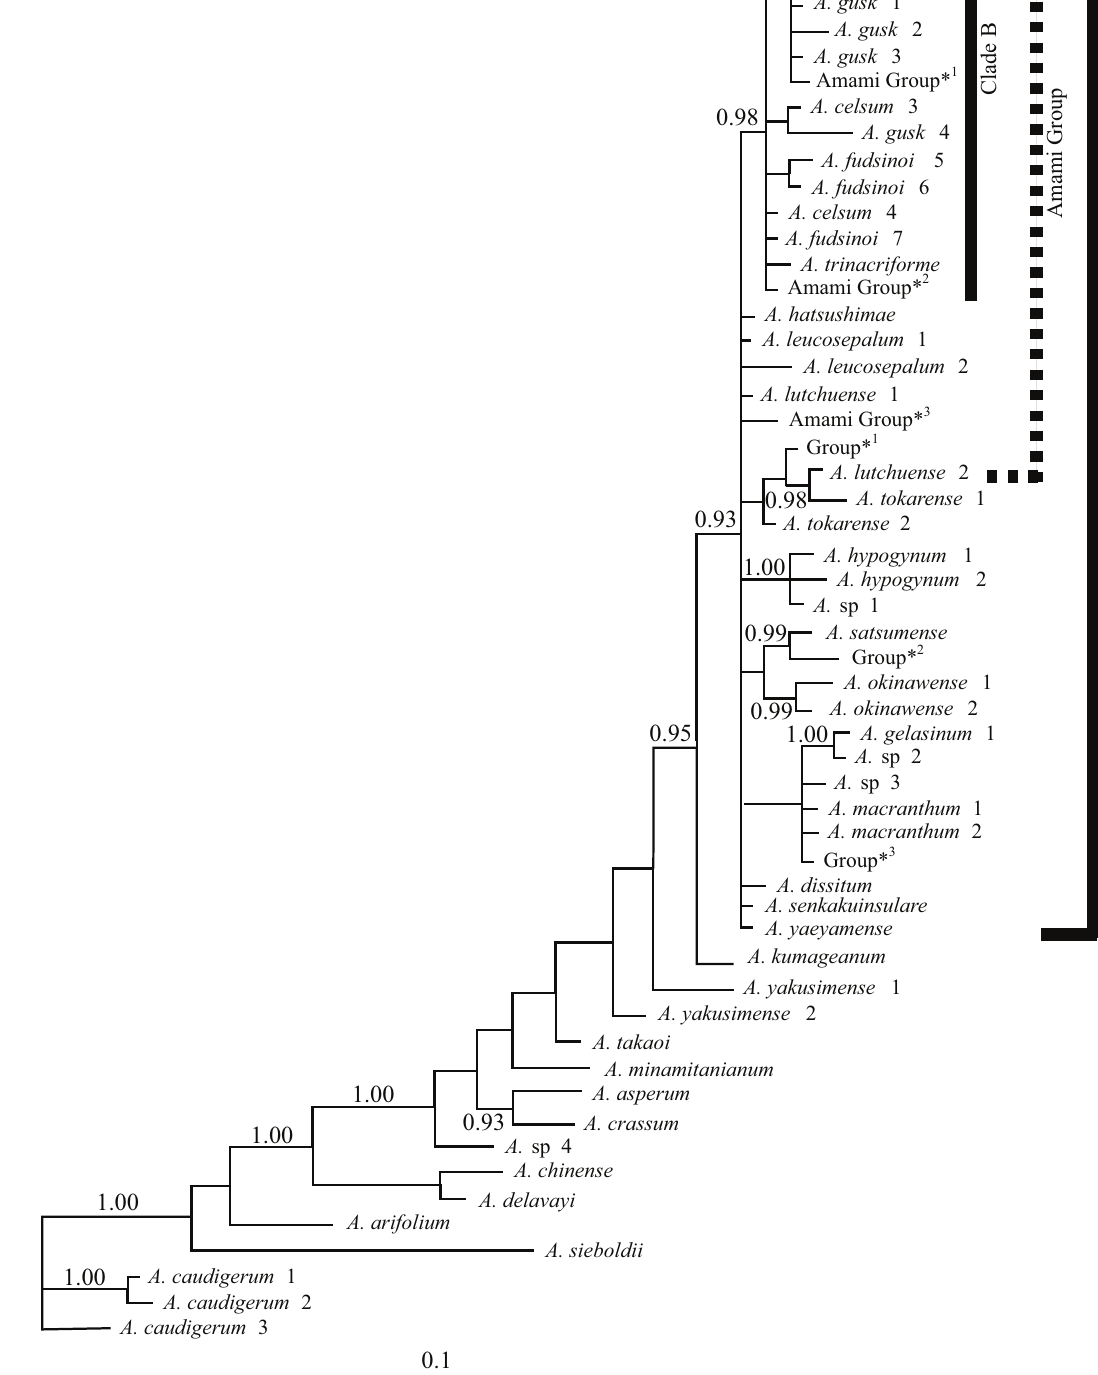
Fig 3. Phylogenetic tree of Asarum generated from a Bayesiananalysis of the ITS region. BPP values in excess of 90% are highlighted.The taxon labels (including Group * 1and Amami Group * 1– * 3)correspond to those used in Table